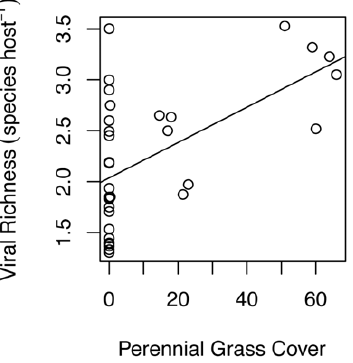
Figure 5. Coinfection (viral species richness per infected host) of five viruses along a gradient of perennial grass cover. The line represents the slope of this relationship.